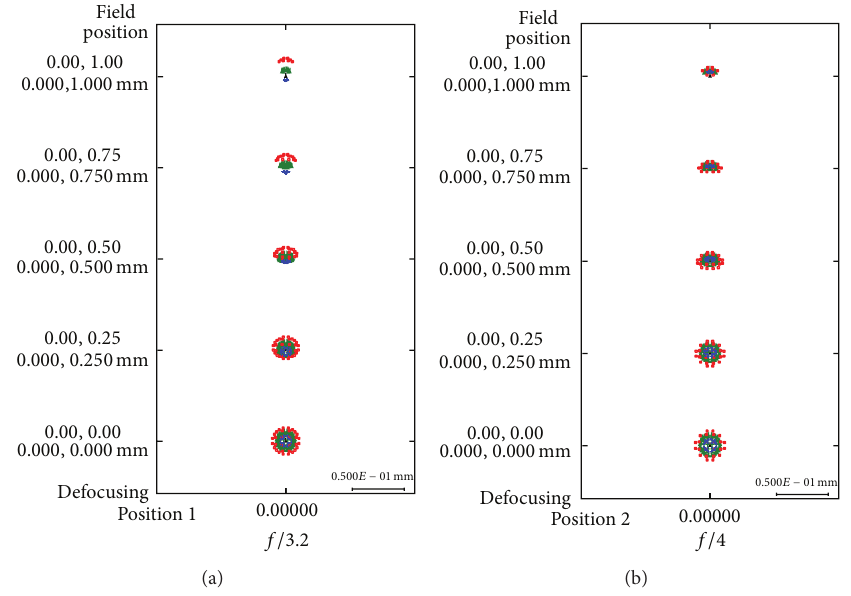
Figure 8: The spot diagram (a) EFL = 5mm and (b) EFL = 7